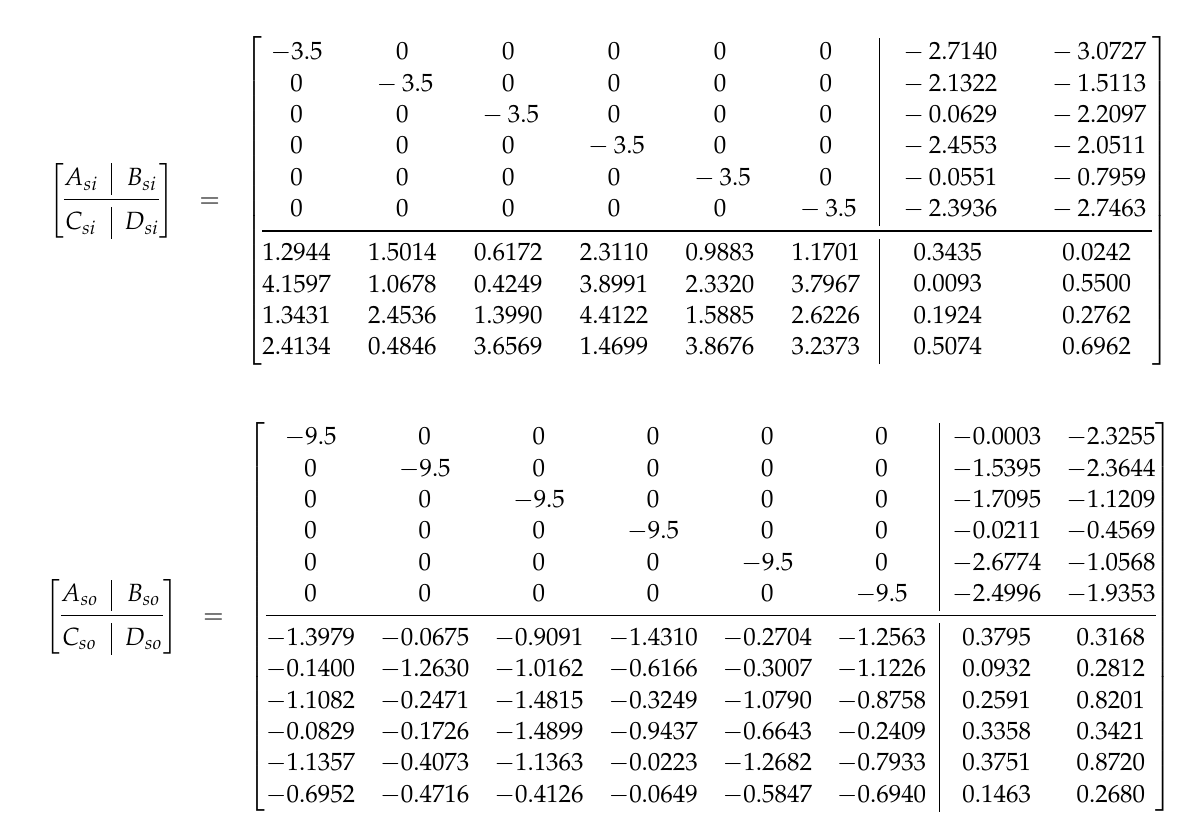
Table 2 give a comparison for the frequency-response error and error